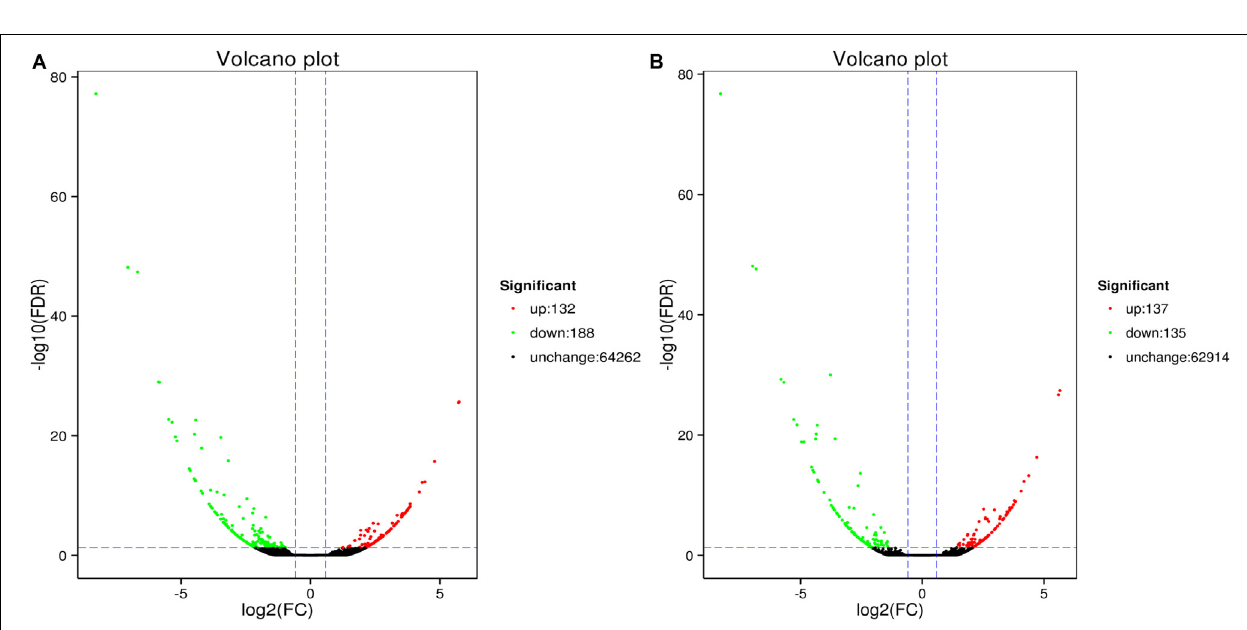
FIGURE 5 | MA plot of differentially expressed genes between ammonia exposure and control group ( A , 48 h; B , 96 h). Volcano Plot of differently expressed genes after ammonia exposure. Each dot represents a gene. X -axis: The logarithmic value of the multiple of the difference in the expression of a gene between two samples, Y -axis: The negative pair value of the error detection